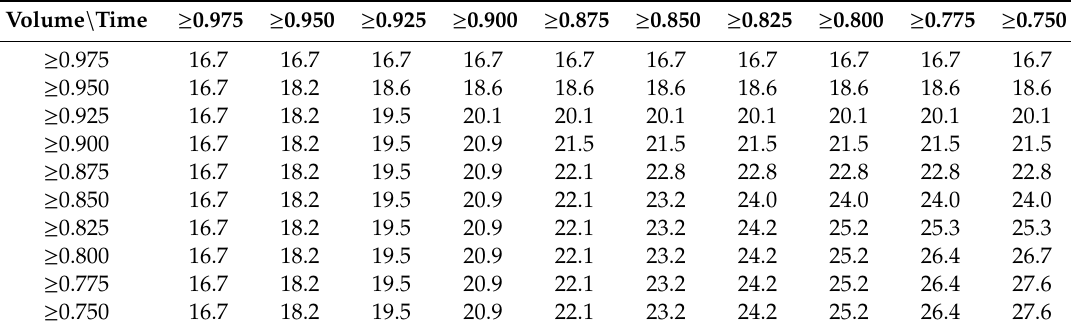
Table 4. The maximum water supply amount of each reliability condition for the Shihmen reservoir (Unit: CMS).